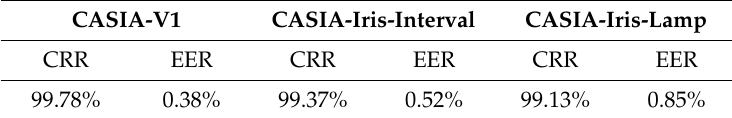
Table 8. The CRR and EER of the meaning of tightness